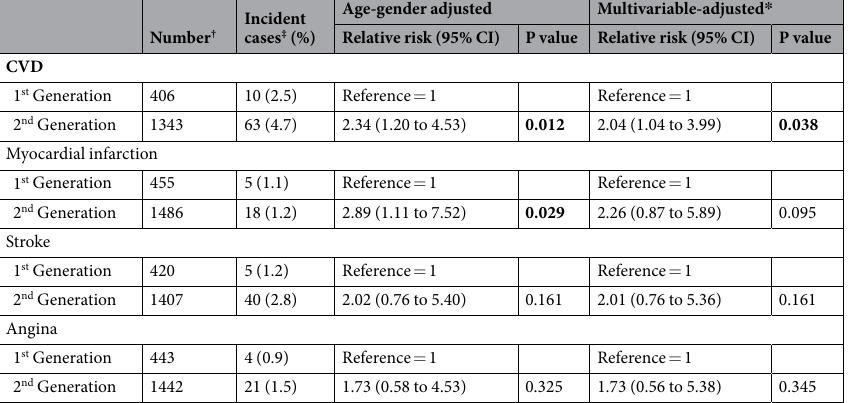
Table 3. Association between generation and incidence of CVD and its sub-types. * Adjusted for age, gender, obesity, low SES (primary or lower education, and individual monthly income < SGD2000), smoking, alcohol, presence of comorbid conditions such as diabetes, hypertension, hyperlipidemia and CKD, use of anti-diabetic, anti-hypertensive and anti-cholesterol medications. Bolded values indicate statistically significant results. † The number of individuals at risk of CVD is not the sum of the number of individuals without each of the constituent conditions (myocardial infarction, stroke and angina) at baseline. For example an individual without myocardial infarction at baseline (at risk of developing incident myocardial infarction) might already have angina and/or stroke and wouldn’t be included in the denominator for CVD. ‡ Number of incident CVD cases is also not the sum of the incidence cases of each constituent condition as individuals could develop more than one condition. CVD = cardio vascular disease; CKD = chronic kidney disease; SES = socioeconomic status.